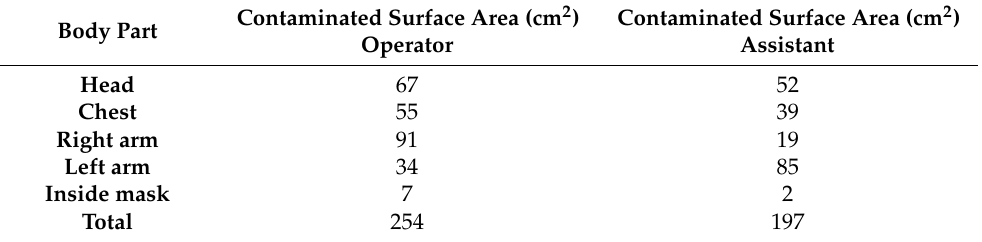
Table 2. Collection of aerosol and splatter on different body parts of the operator and